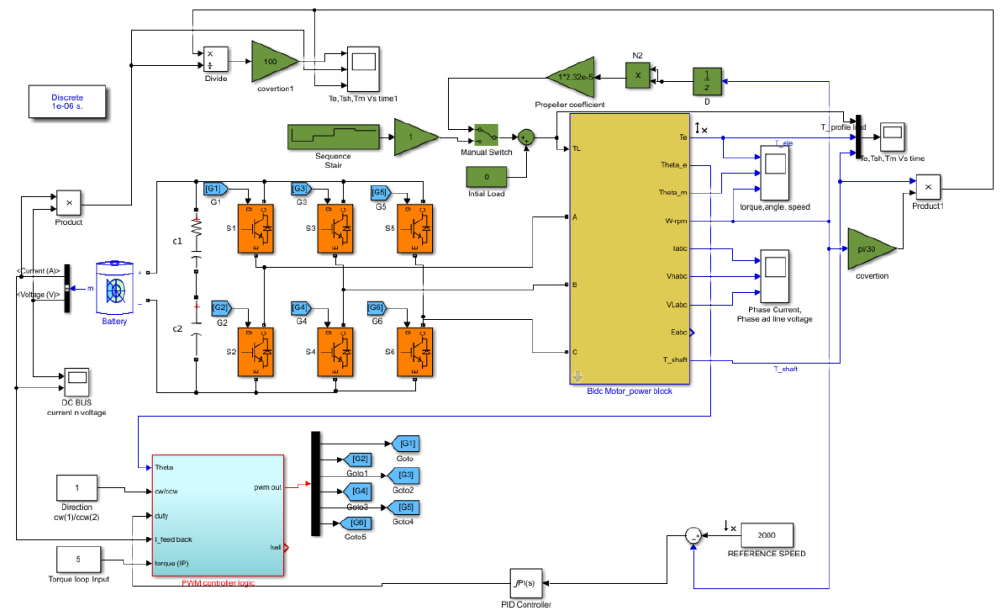
Figure 10. Simulation of PMBLDC motor with PWM-PWM logic and advanced angle method.